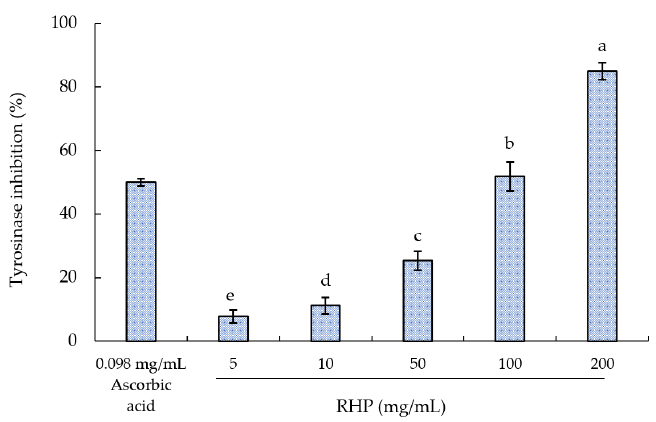
Figure 7. Effect of RPH concentration on tyrosinase-inhibitory activity. Means not sharing a common superscript are significantly different ( p < 0.05).